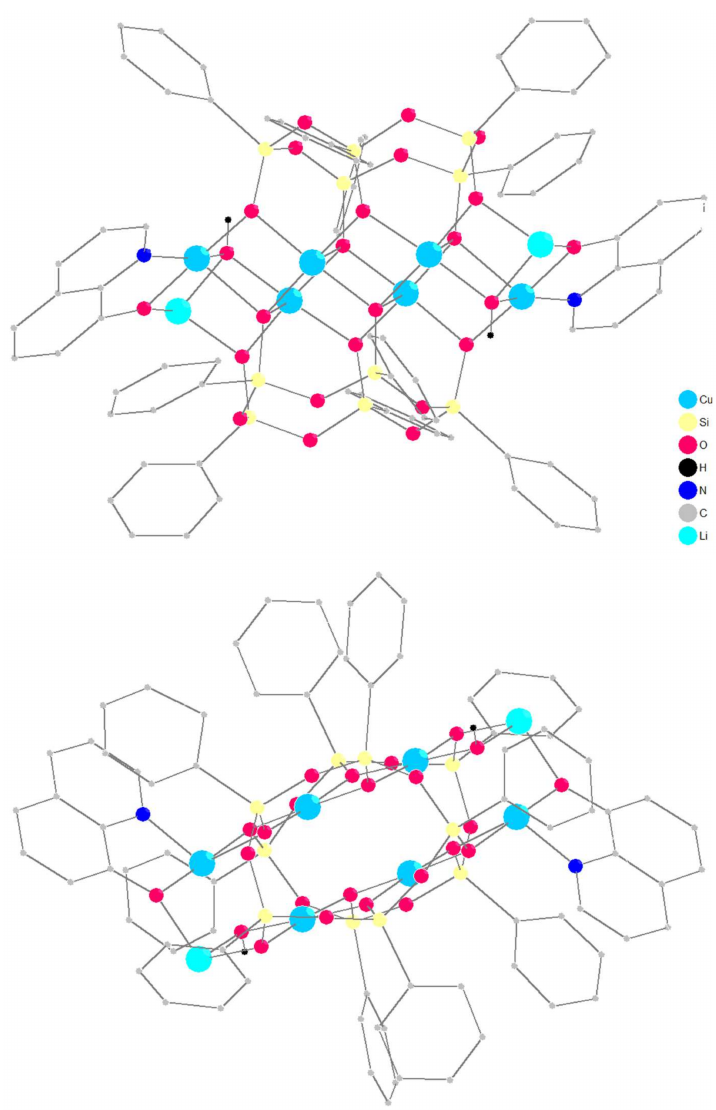
Figure 1. Two projections of the molecular structure of 1